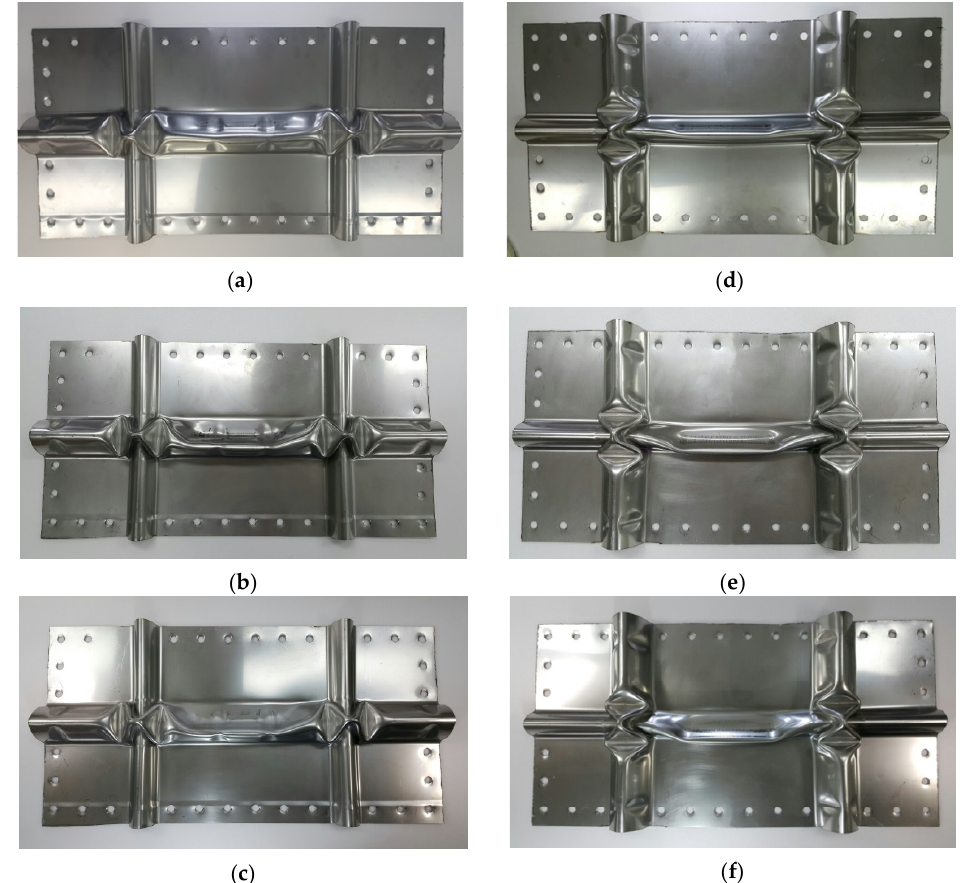
Figure 9. Deformed configuration of the L123 scenario specimen under ( a ) the first impact loading, ( b ) the fifth impact loading and ( c ) the tenth impact loading, and of the S123 scenario specimen under ( d ) the first impact loading, ( e ) the fifth impact loading, and ( f ) the tenth impact loading. Although the deformation of a large corrugation is accompanied by a distortion of the knot part, the deformation of a small corrugation did not distort the butterfly wing shape of the knot. However, as a small corrugation is deformed with repeated impacts, the affected zone caused by